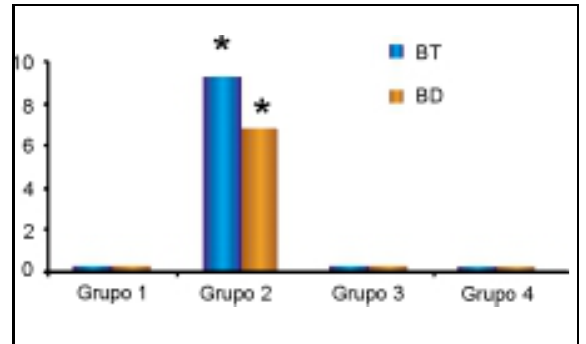
FIGURA 5 - Gráfico informando os valores da Bilirrubina total e bilirrubina direta (mg/dL), (* = p < 0.05).